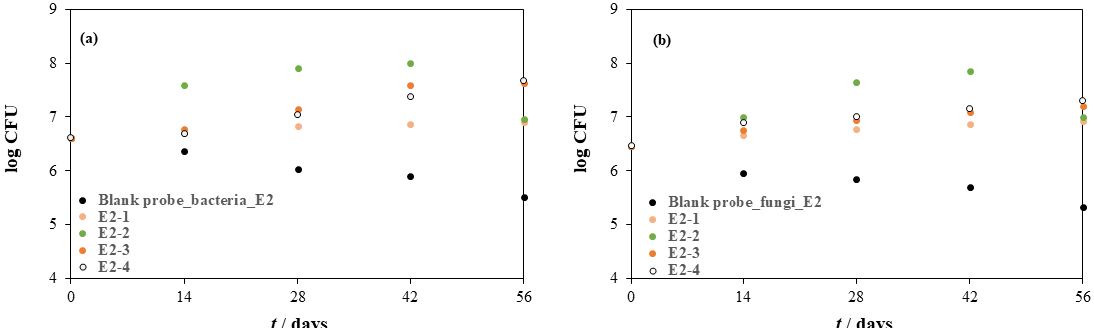
Figure 5. Change of CFU of bacteria ( a ) and fungi ( b ) in experiments E2 during 56 days of biodegradation experiments.